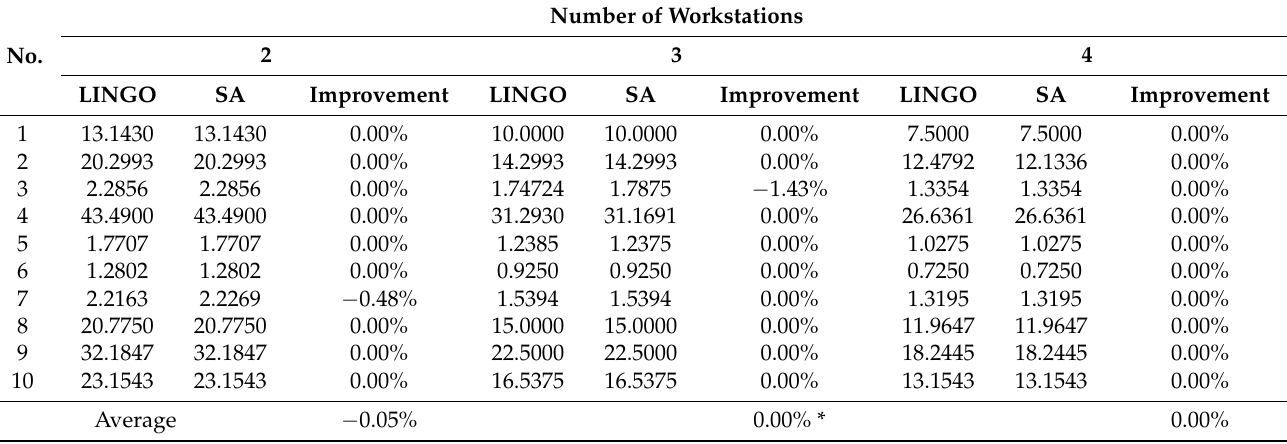
Table 3. The cycle times of experimental results for small problems ( b = 15% of length of the